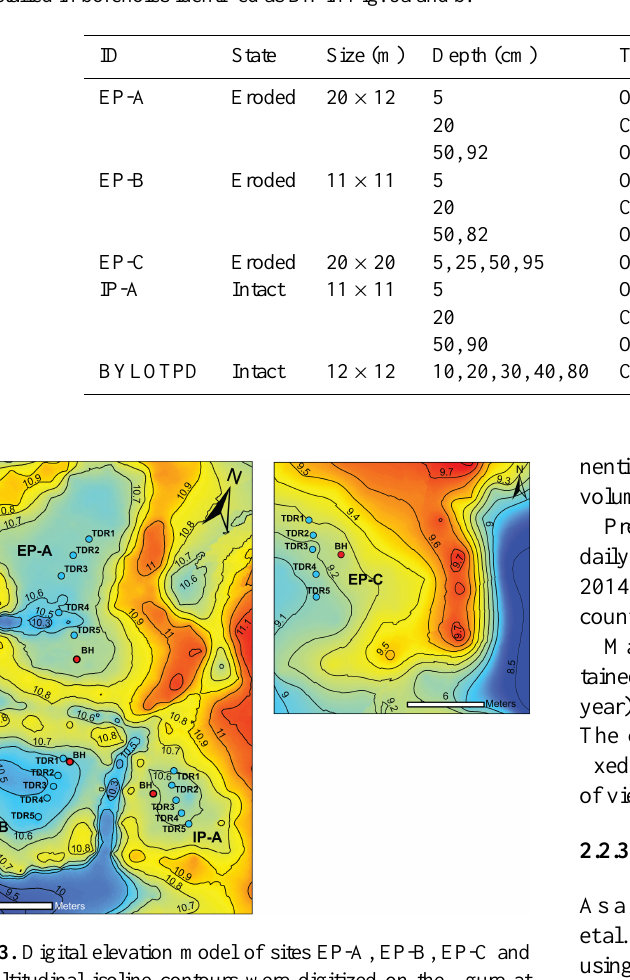
Table 1. Sites’ specifications, presenting polygon’s ID, state (either intact or eroded), size (major and minor axis) and sensors deployed are shown. A complete gully erosion map model was presented in Godin and Fortier (2012b) (Fig. 3). Size was obtained by measuring the length and the width of each polygon by calculating the distance from the highest point of surrounding ridges, near their troughs. The Campbell Scientific temperature sensors (model 107-L) and Omega Type-T thermocouples were connected to a CR1000 datalogger. The Onset S- with TDR sensors (EC-5). BYLOTPD is equipped with a 3m long custom-made thermistor cable (Allard et al., 2014). Temperature sensors were installed in boreholes identified as BH in Fig. 3a and b.